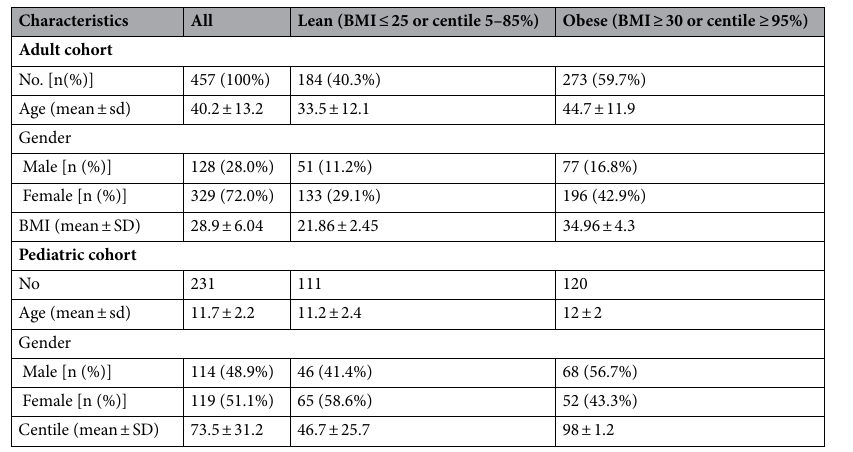
Table 1. Description of the study